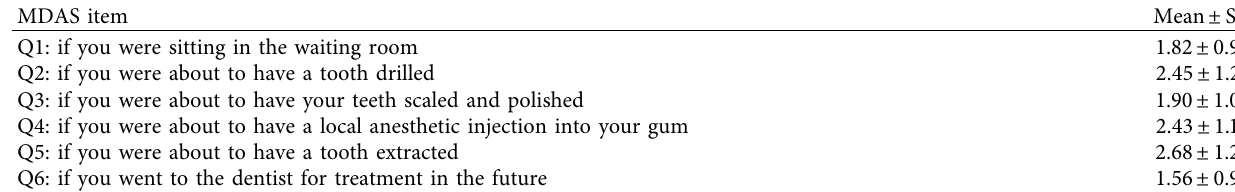
Table 2: Means and standard deviation of Modified Dental Anxiety Scale items.